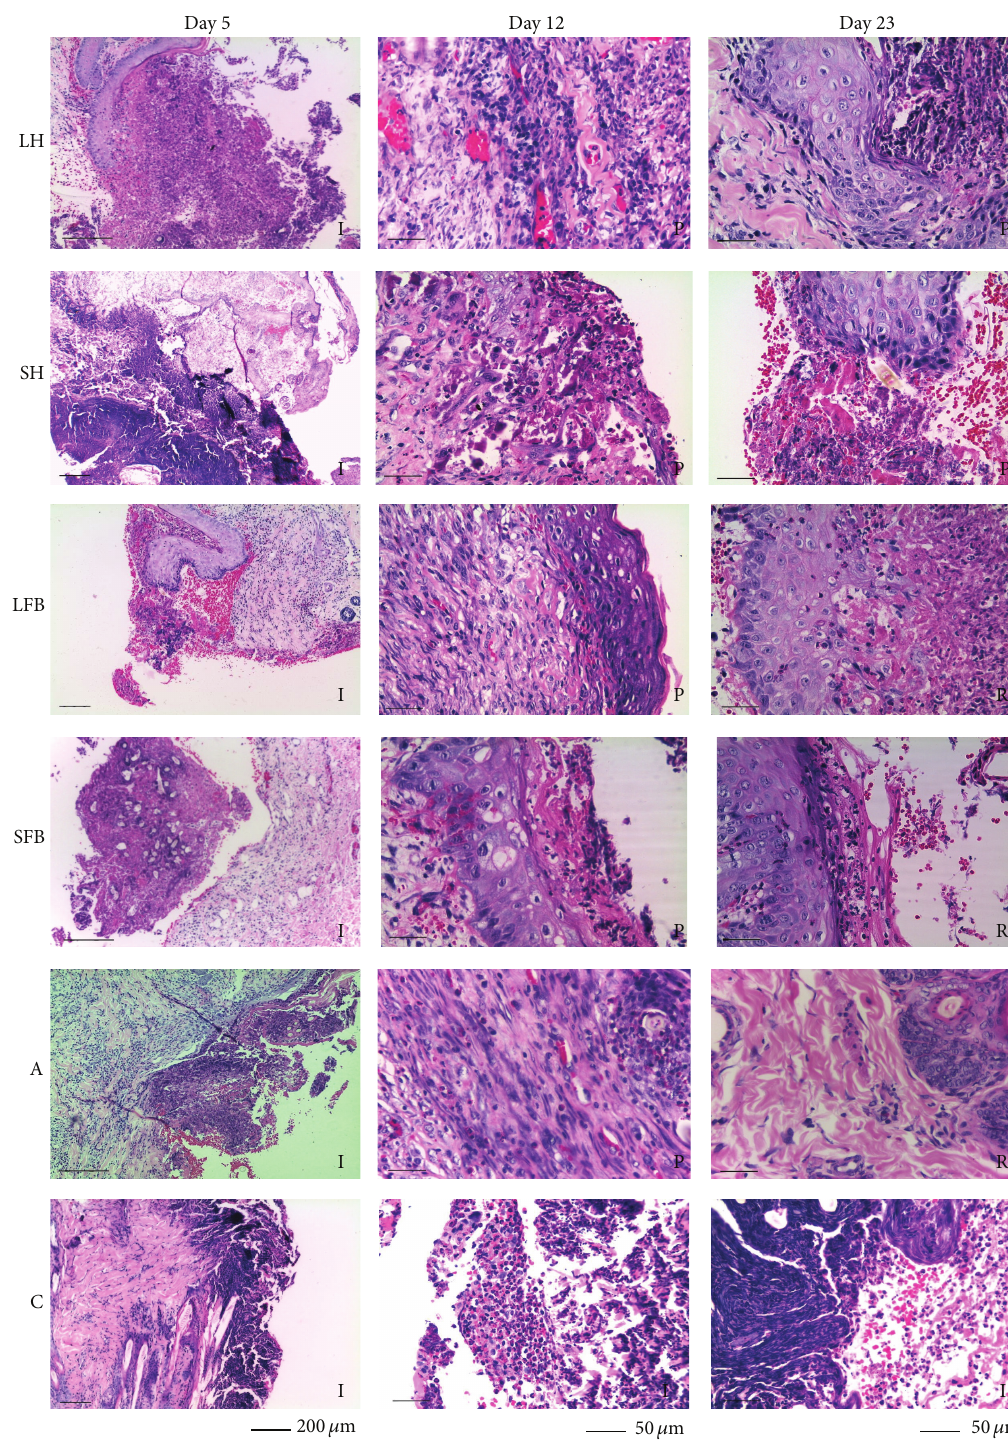
Figure 3: (HE) Histology regarding the evaluation of wounds throughout the healing phases involved in treatment with LH: Lucilia sericata haemolymph-derived larval therapy, SH: Sarconesiopsis magellanica haemolymph-derived larval therapy, LFB: Lucilia sericata fat body- derived larval therapy, SFB: Sarconesiopsis magellanica fat body-derived larval therapy, A: antibiotic, and C: control, on days 5, 12, and 23 of the experiments. (I) Inflammation, (P) proliferation, and (M) maturation. The I sections of the figure show abundant inflammatory cells, P the presence of fibroblasts, and M base lamina formation and collagen